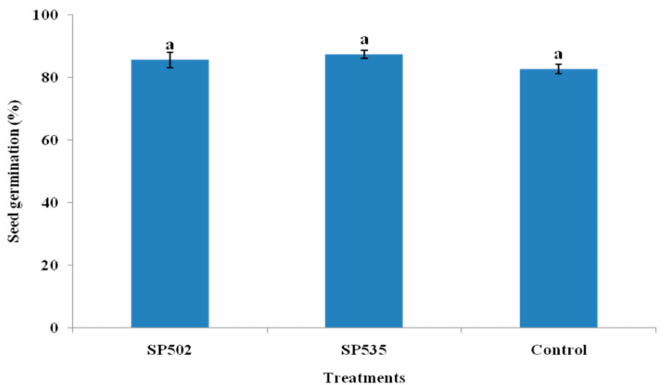
Figure 1. E ff ect of Cordyceps fumosorosea isolates on percent germination of eggplant seeds. Error bars indicate the standard error of means based on five replicates (n = 5). Bars having di ff erent letters indicate that means are significantly di ff erent from each other at a 5% level of